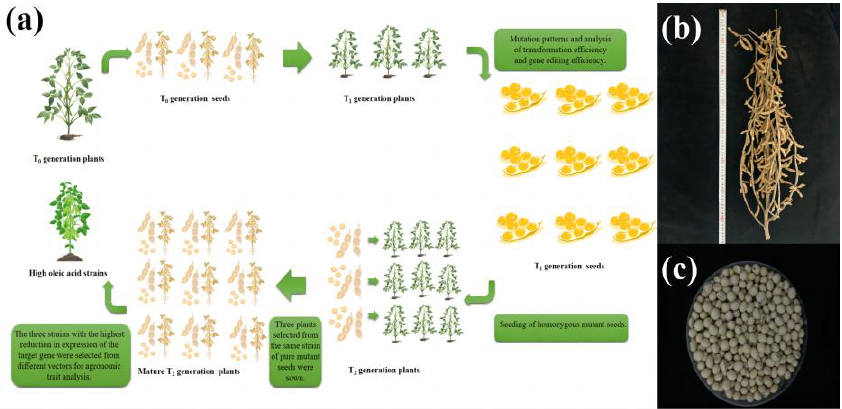
Figure 1. Overview of the gene editing plant creation process and phenotype: ( a ) gene editing breeding process; ( b ) gene editing positive plants; ( c ) gene editing positive seeds.